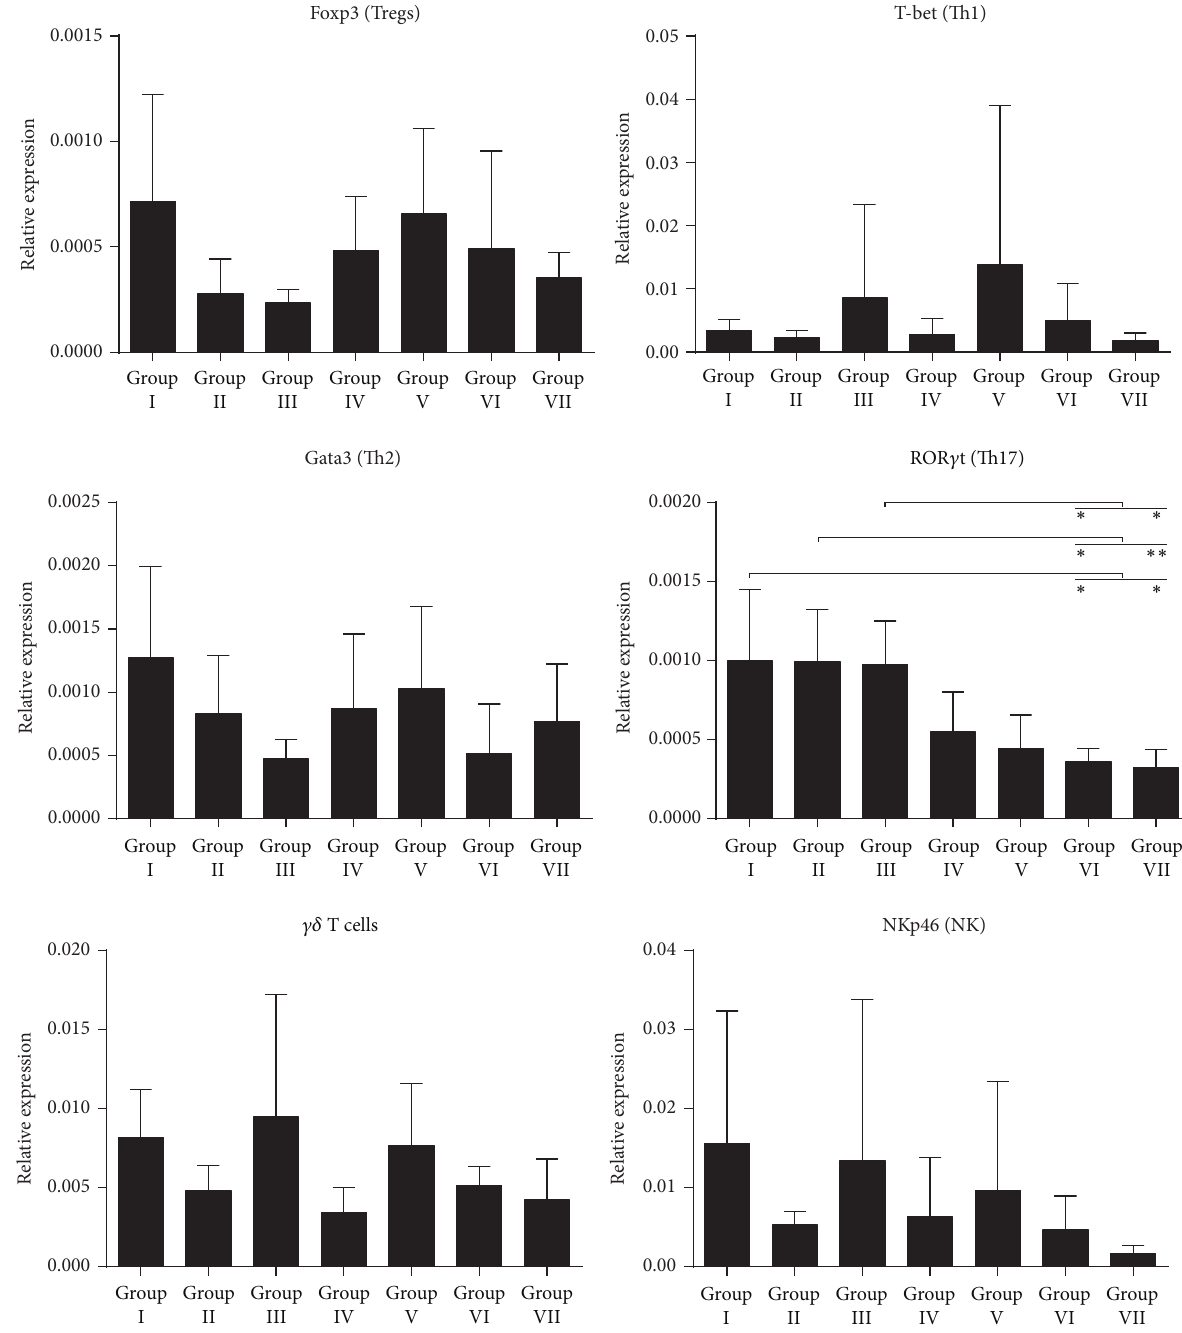
Figure 4: mRNA analysis of transcription factors from the jejunum, reflecting the presence of Tregs, Th1, Th2, TH17, and 𝛾𝛿 T and NK cells. ∗ denotes 𝑝 < 0.05 and ∗∗ denotes 𝑝 < 0.01